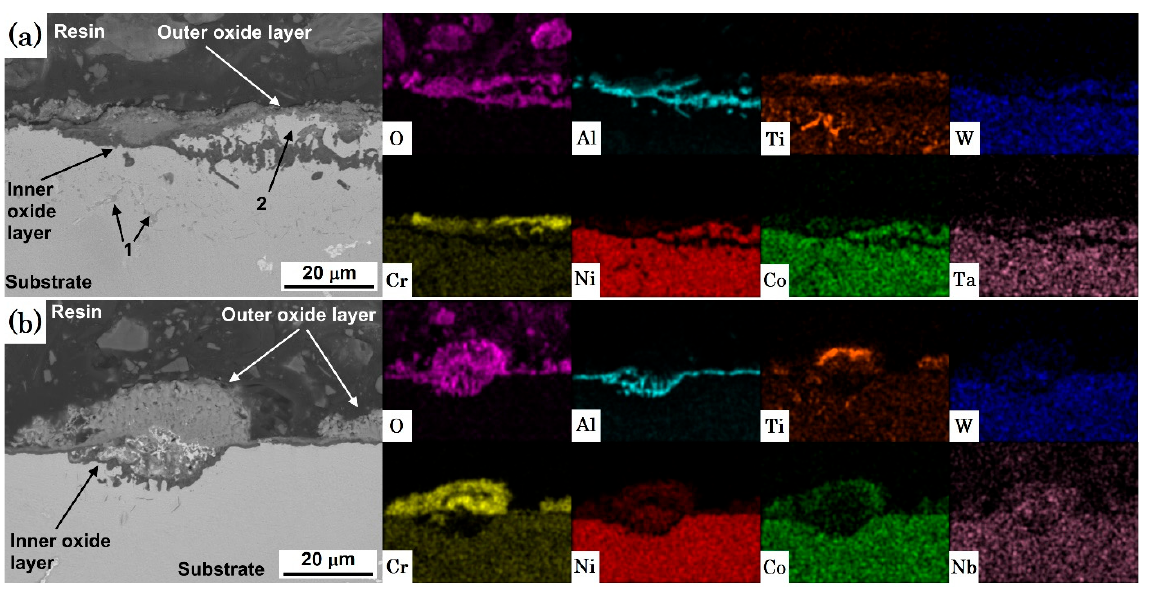
Figure 5. SEM and EDS mapping of elements for 180 cycles at 1000 °C on the cross-section of the specimens. ( a ) MAR-M246(Ta), ( b ) MAR-M246(Nb).